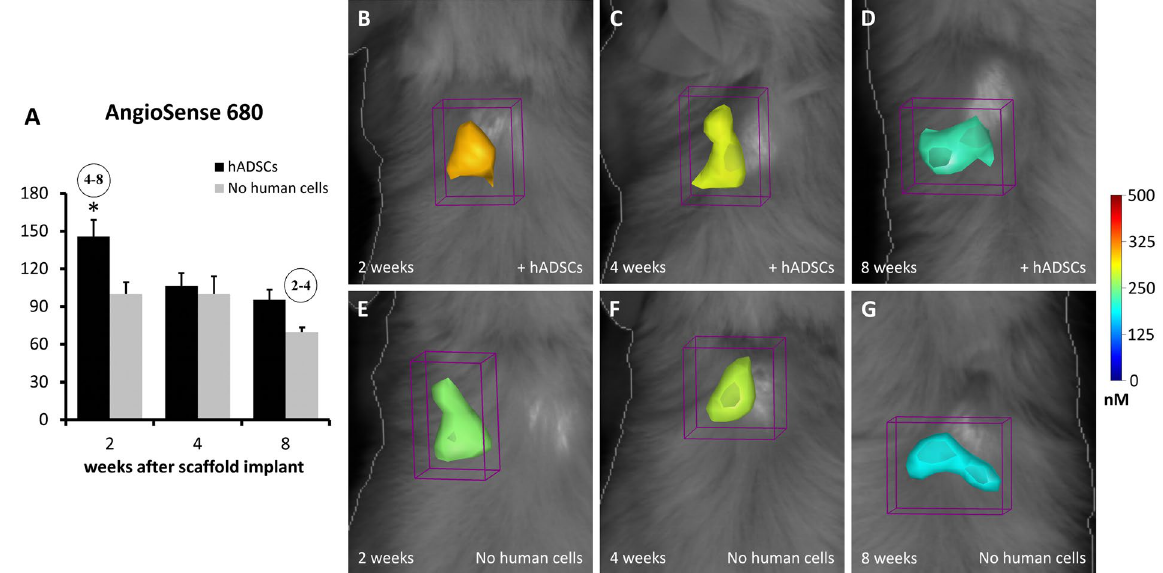
Figure 4. FMT images and in vivo quantification of angiogenesis within the implanted scaffolds. The color scale indicates the mean fluorescent probe concentrations within the ROI, and the graph ( A ) shows the mean values of probe content (in pmol) calculated within groups and reported as percent of the mean value of the 2 wk group with cell-free scaffold. A higher concentration of AngioSense 680 is present when the scaffolds contain hADSCs, especially at 2 and 8 weeks ( B , D ) when compared with cell-free scaffolds ( E – G ). In the graph A, the numbers into the circles indicate significant differences (P < 0.05) from the corresponding time-points, in weeks (same treatment groups), while the asterisk indicates significant difference (P < 0.05) from the other treatment group (same